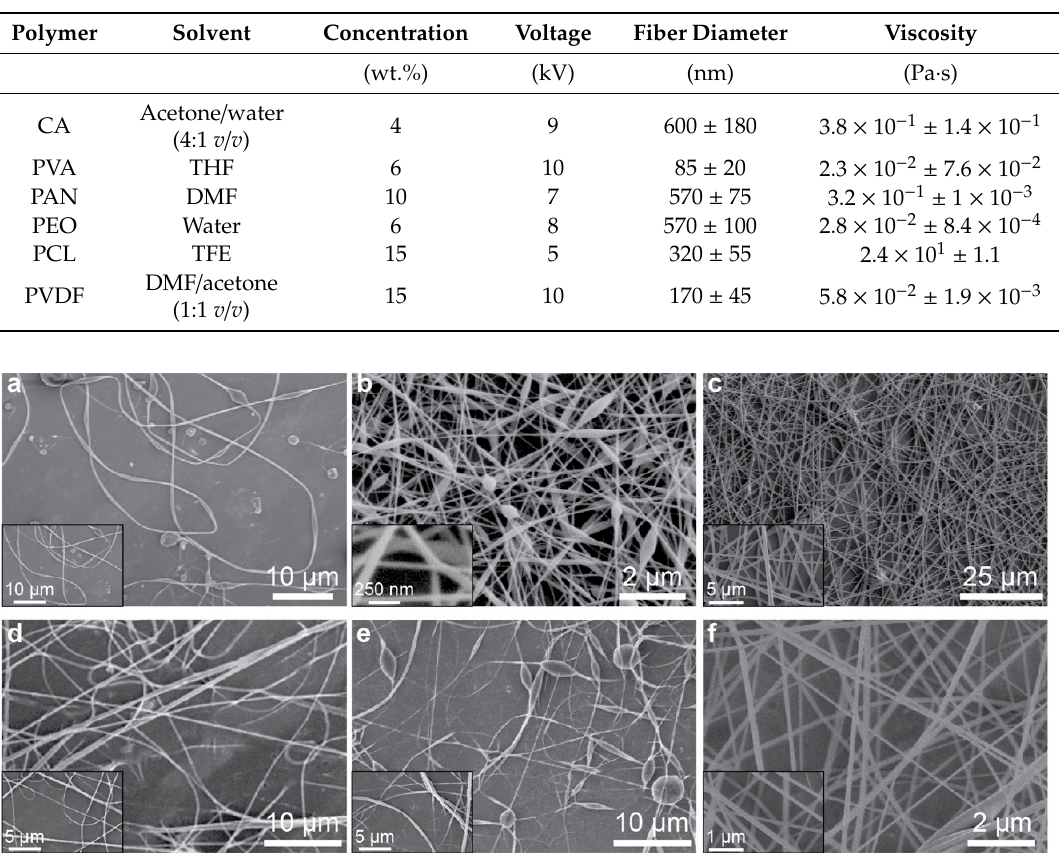
Table 1. Electrospinning parameters and measured nanofiber diameter.